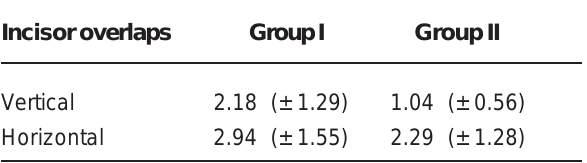
TABLE 4- Pearson’s correlation coefficients for Group II